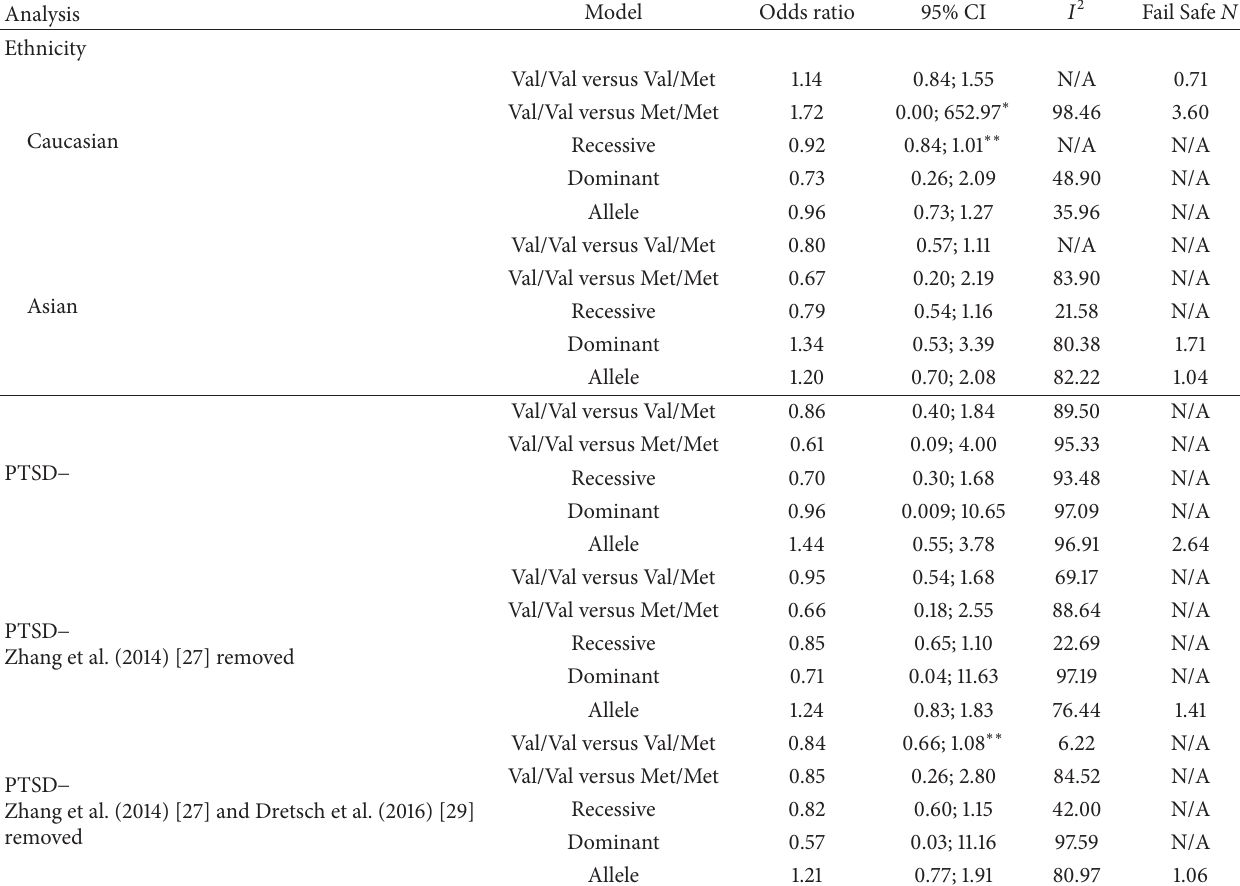
Table 7: Results from the subgroup analyses with and without Zhang et al. (2014) [27] and Dretsch et al. (2016) [29] from the random-effects